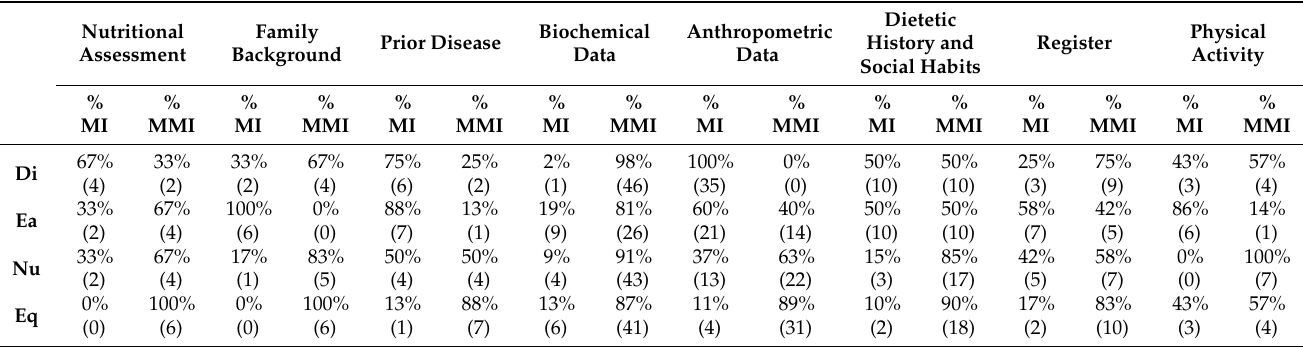
Table 3. Assessment of matching and mismatched items.